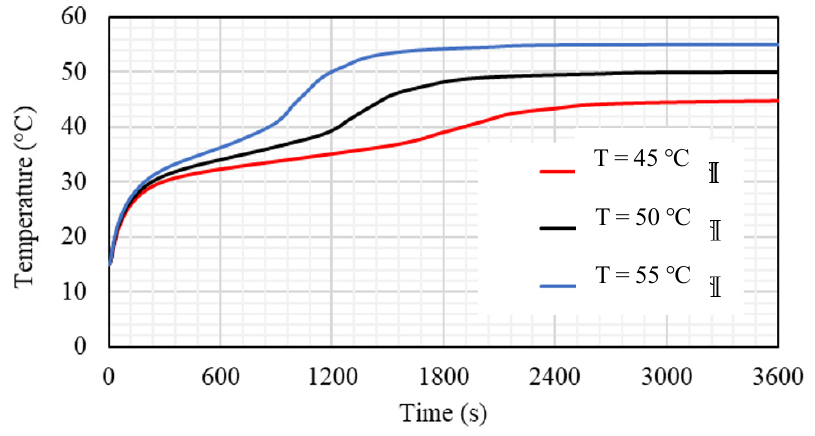
Figure 18. The average temperature of the PCM for the case 3b (Re equals 1000) at different values of inlet HTF temperature (Tin = 45 °C, Tin = 50 °C, and Tin = 55 °C). Table 4. Melting time until achieving 95% and the heat-transfer rate in 1800 s for the cases of inlet HTF temperature of Tin = 45 °C, Tin = 50 °C, and Tin = 55 °C.